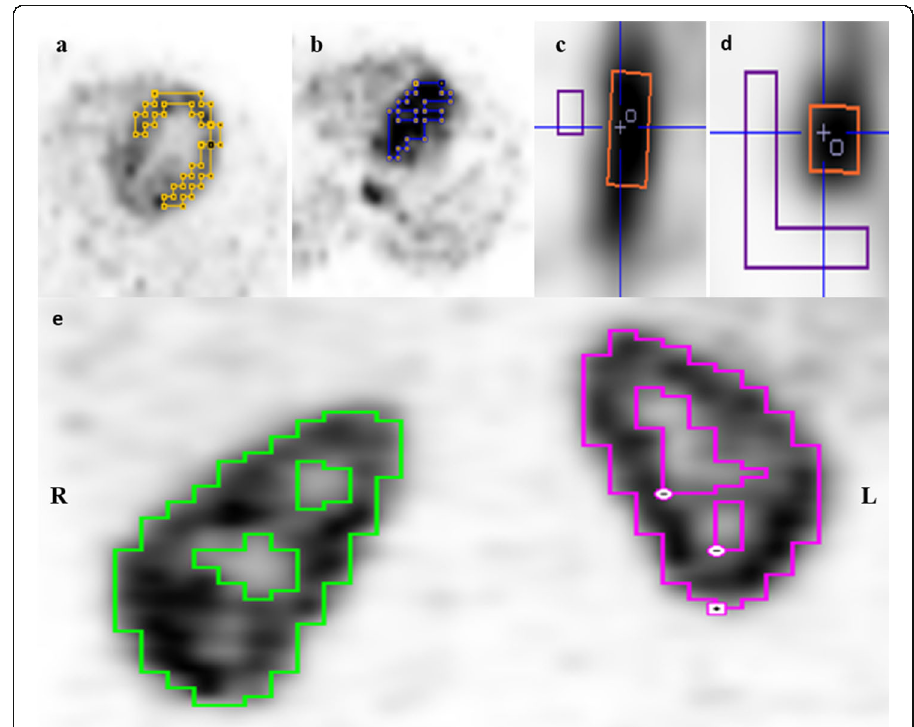
Fig. 4 VOIs were drawn in a myocardium, b left ventricular blood pool, c and d abdominal aorta and aortic background (orange — aorta; purple — background) and e contouring the kidneys (green — right; cerise —